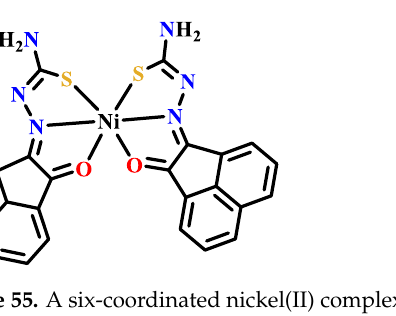
44 of 58 Figure 54. The novel symmetric tetranuclear Pd(II)/Pt(II) complexes of pyrene hydrazone with ( N - ethyl/phenyl)-substituted thiourea as a side chain. As early as 1997, Maria C. Rodriguez-Arguelles et al. [138] reported a new acenaph- thehydrazone ligand with thiourea as a side chain and coordinated it with iron(II), nickel(II), copper(II), and zinc(II) to form four corresponding metal complexes (Figure 55). The structures were characterized by IR and NMR. It was observed for the first time that an acenaphthehydrazone ligand could inhibit cell proliferation and induce cell differenti- ation in the tested dose range. The acenaphthehydrazone ligand achieved 40% inhibition of DMSO- induced cell differentiation at 2 or 9.3 μg/mL, much higher than the correspond- ing ligands that had been previously reported, and failed to detect activity at higher doses (30 μg/mL). However, the Zn(II), Ni(I I), and Fe(II) complexes showed a strong inhibitory effect on DMSO-induced cell differentiation, although they had no obvious inhibitory ef- fect on cell proliferation at low doses. At low concentrations (2 μg/mL), they could achieve a 50~90% inhibition rate on DMSO-induced cell differentiation. Although the Cu(II) com- plex showed moderate activity, it was obviously lower than the metal complexes of other series of thiourea. Confusingly, the Cu(II) complex showed no inhibitory activity on